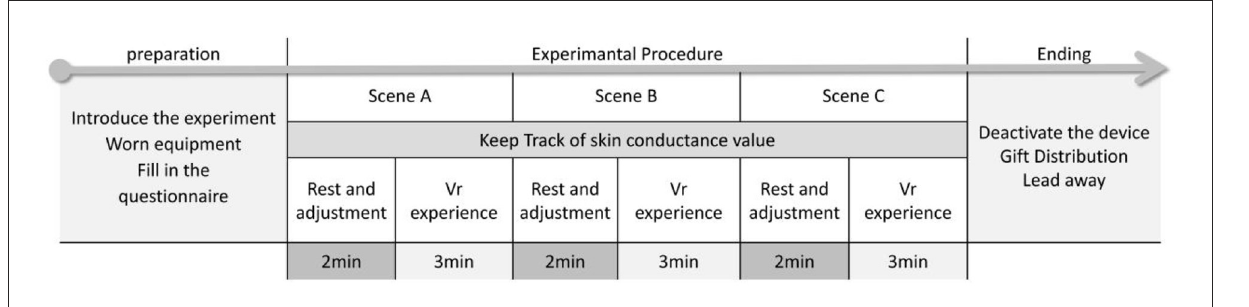
FIGURE6 Flow chart and time distribution of single